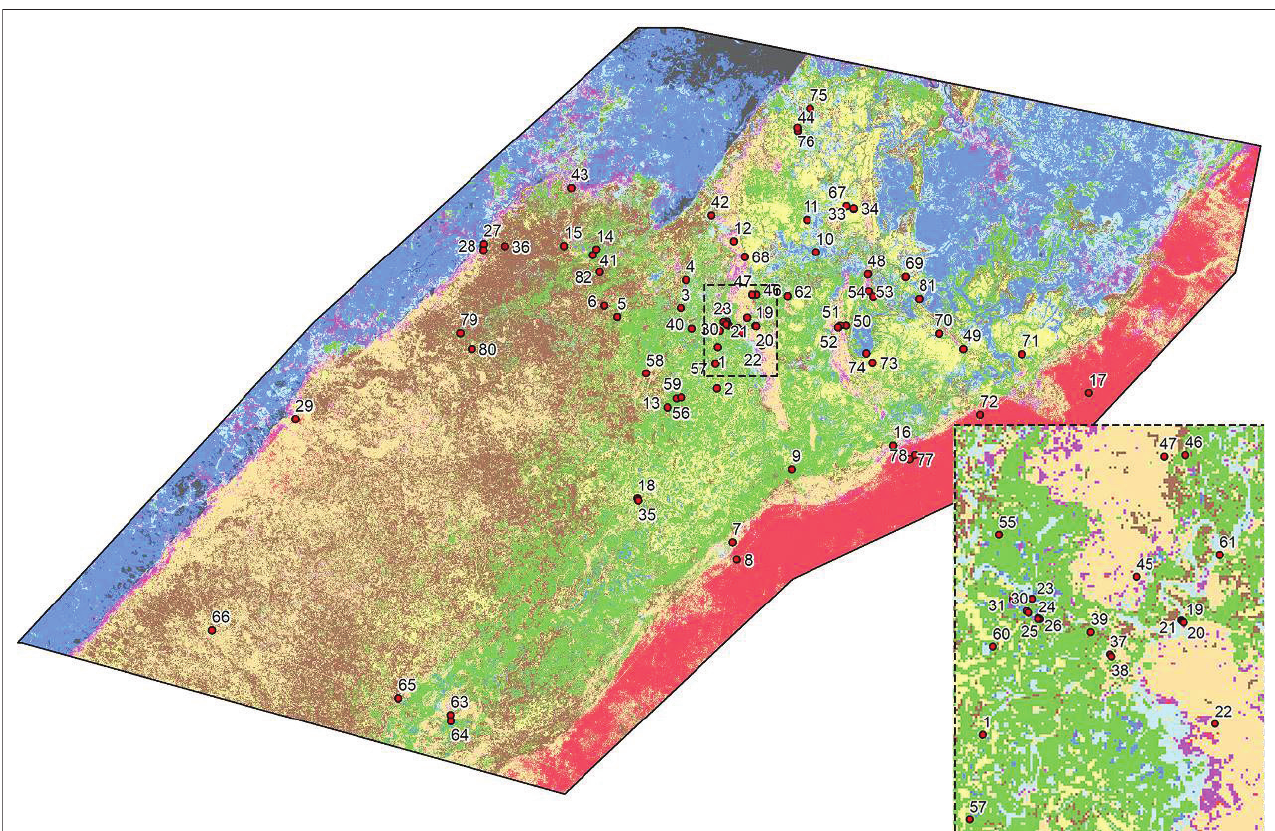
FIGURE 1-A2: Distribution of the 82 sampling plots in the Chobe Enclave. The inset on the right is an enlargement of the central